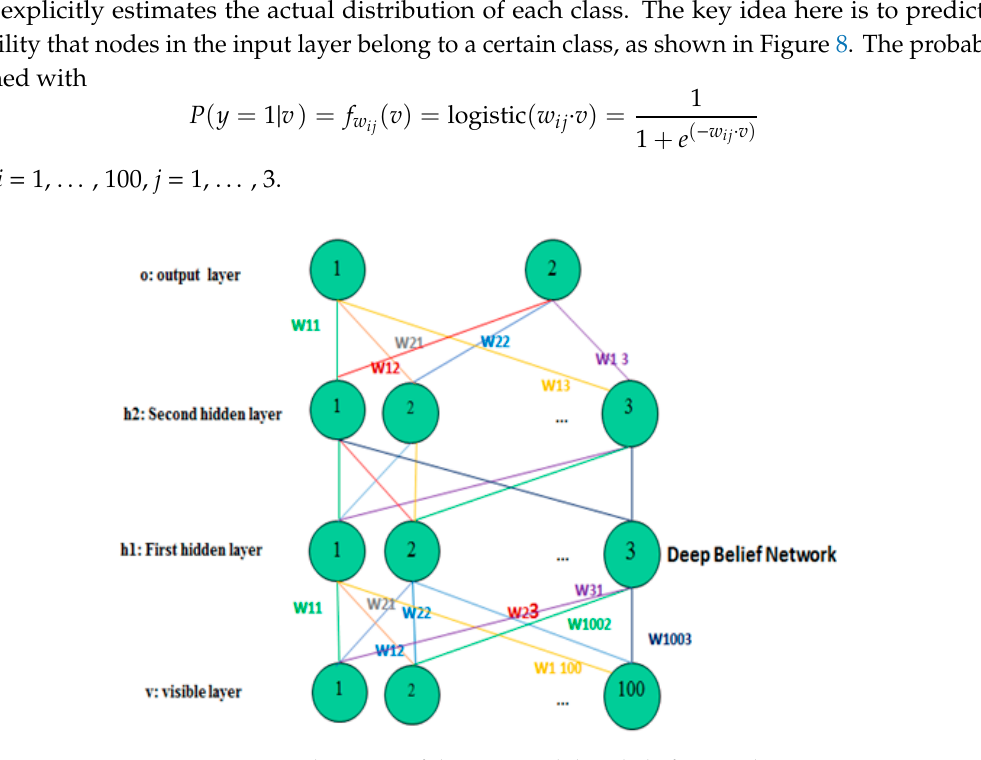
Figure 8. Architecture of the proposed deep belief network.